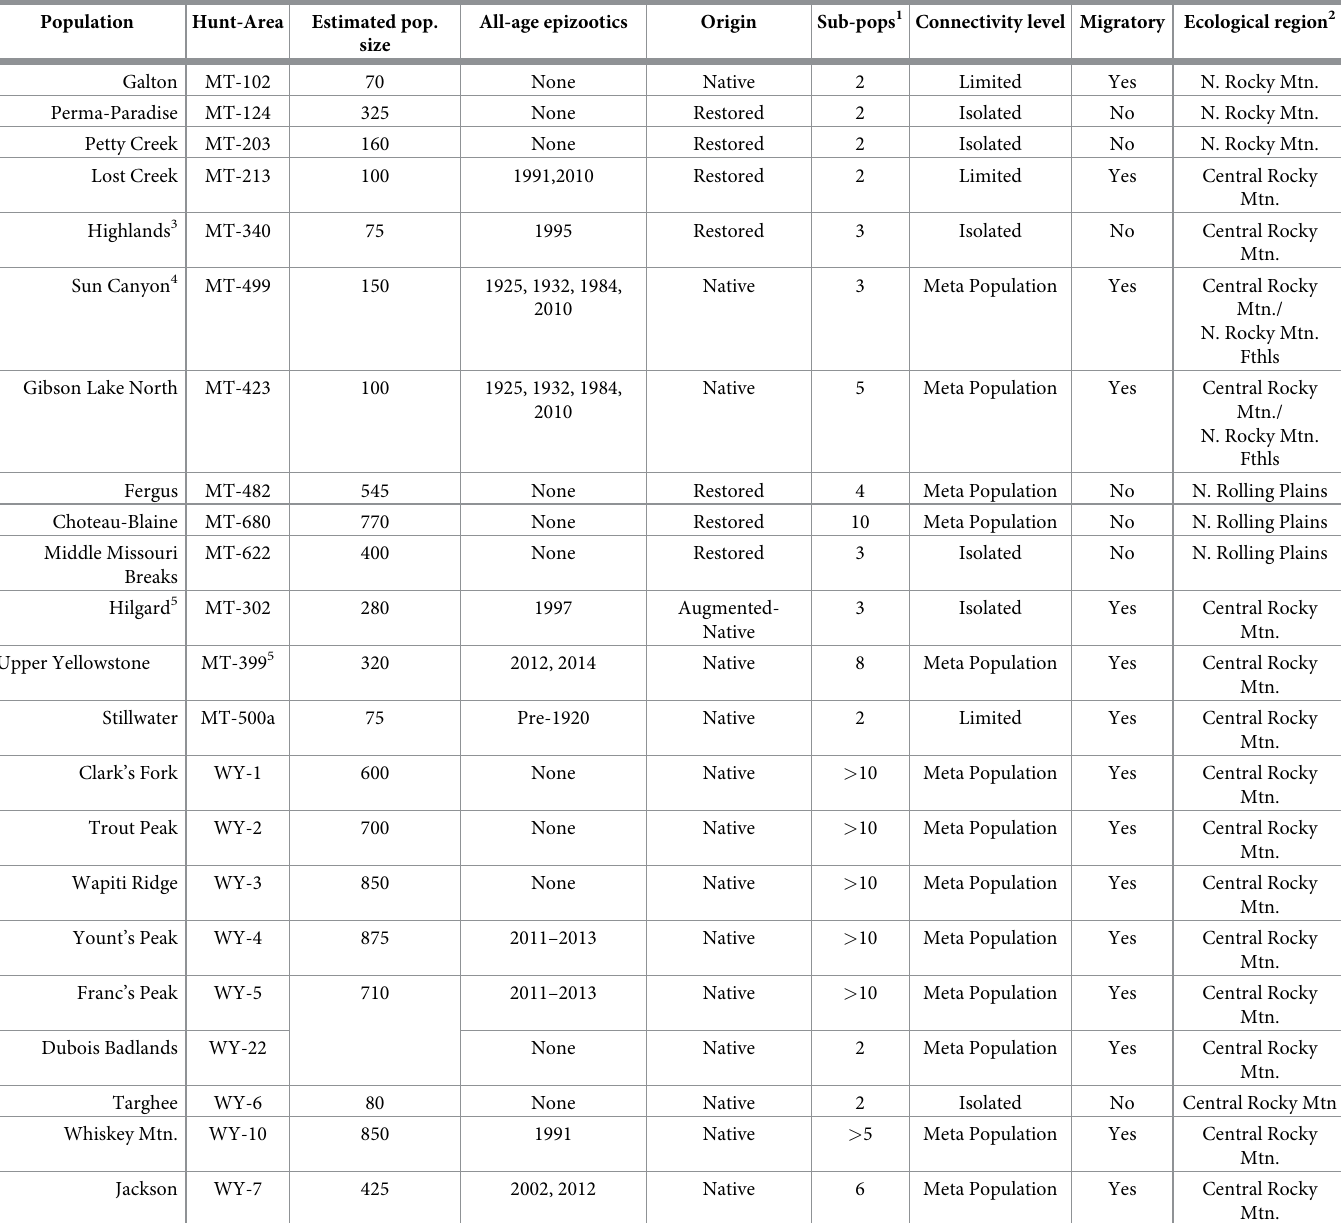
Table 1. General attributes of the 22 bighorn sheep populations investigated in this study.